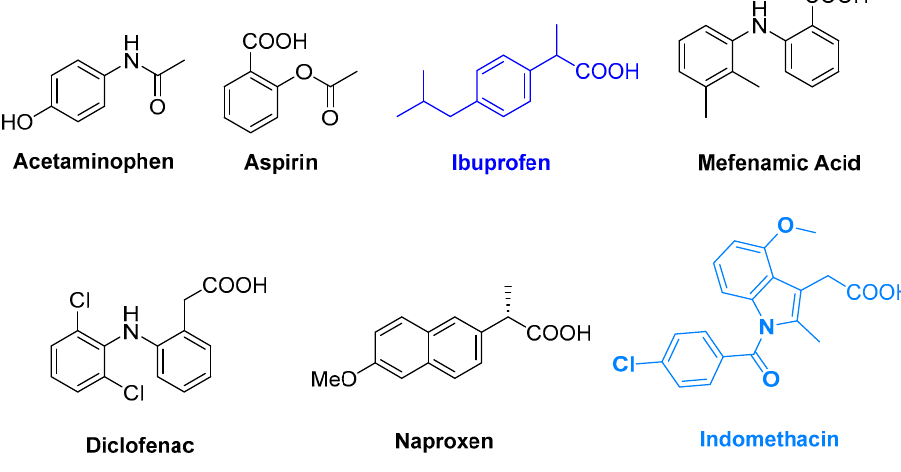
Figure 1. Clinically approved